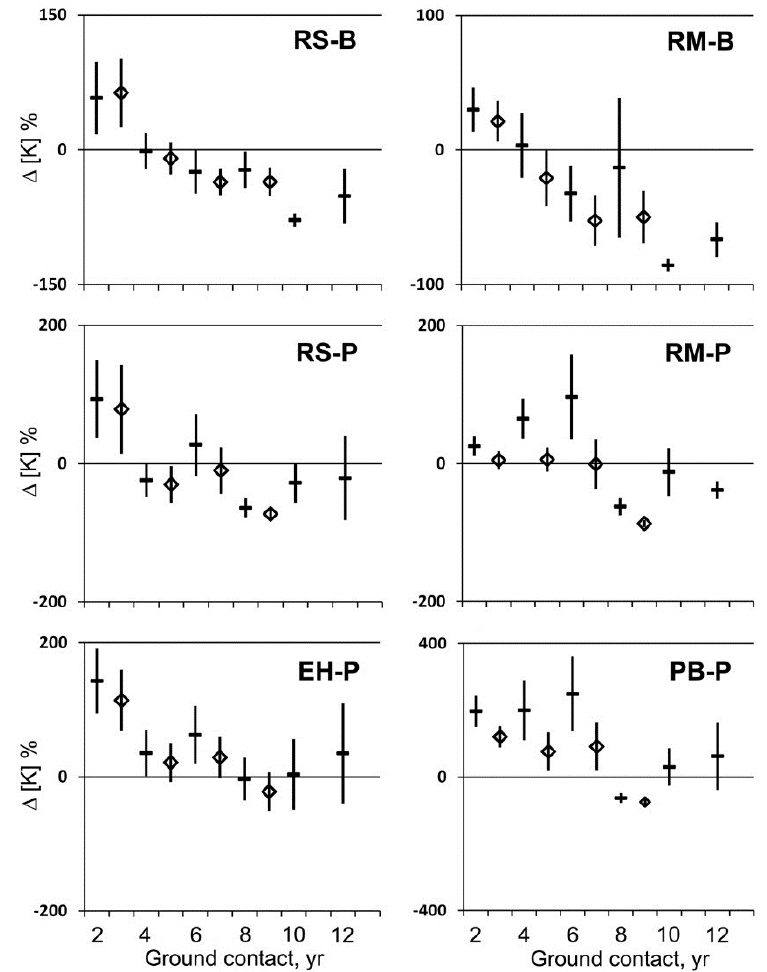
Figure 4. Mean change in potassium concentration per unit mass (dash) and per unit volume (diamond) and 95% confidence interval ( n = 20) for red spruce (RS), eastern hemlock (EH), red maple (RM), and paper birch (PB) at the Bartlett Experimental Forest (B) or the Penobscot Experimental Forest (P) during two to 12 years of decay with ground